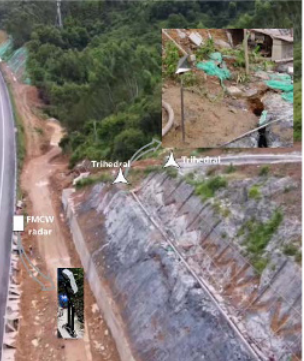
Fig. 4. Test scenario. The radar is installed on the side of the highway and the targets are on the slope.